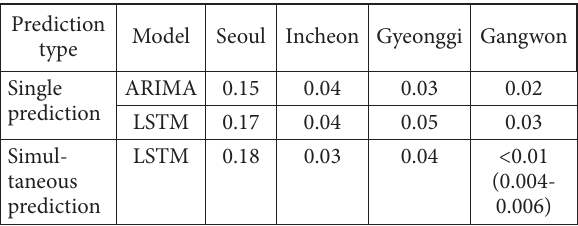
Table 1. MSEs for the house price predictions